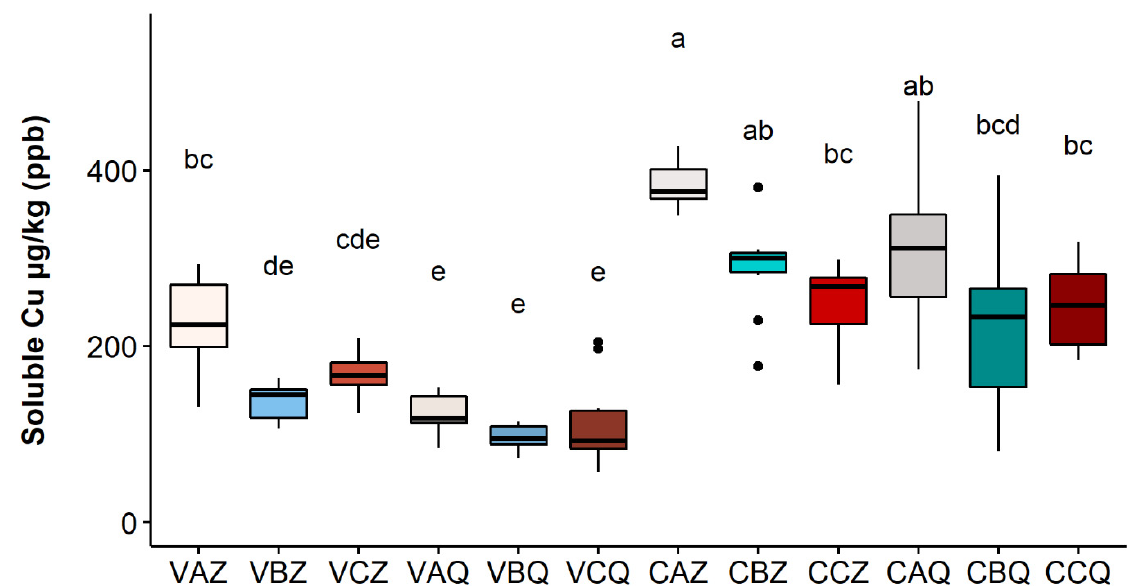
Figure 5. Soluble Cu concentration in each sample in 2020. Lower case letters refer to Dunn’s multiple comparisons (Benjamini–Hochberg p -value adjustment, α -level = 0.05). Code legend: the first letter refers to the vineyard; (C) Castelplanio, (V) Varano. The second letter refers to the thesis: (A) Cu treatments, (B) Alternate treatments with Cu and chitosan, and (C) Chitosan treatments. The third letter refers to the depth: (Z) 0–20 cm, (Q) 20–40 cm.